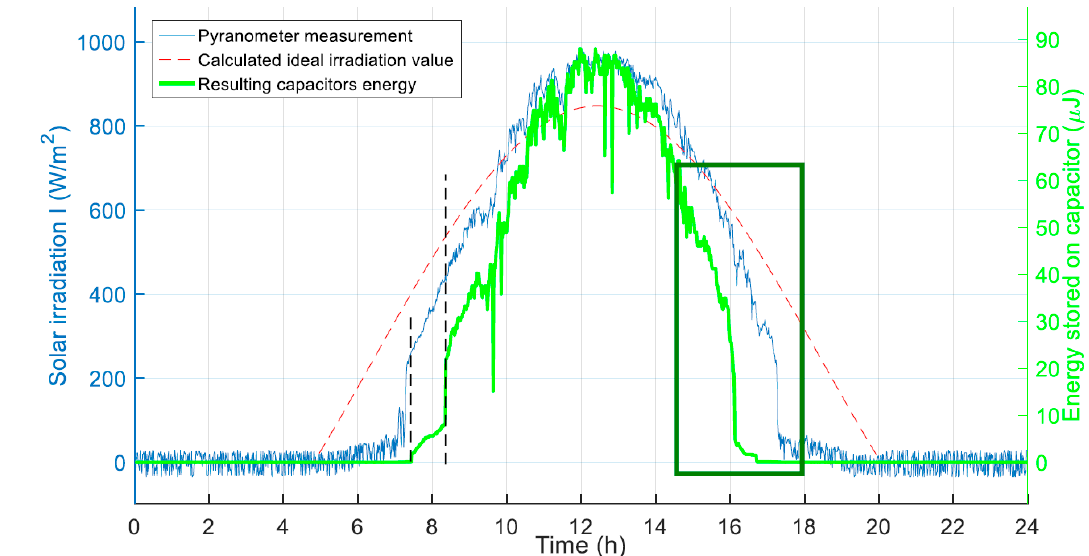
Figure 5. Measurement of the energy income estimated with the stated system and compared to the measured global radiation, at the 22 April 2018 in Freiburg,